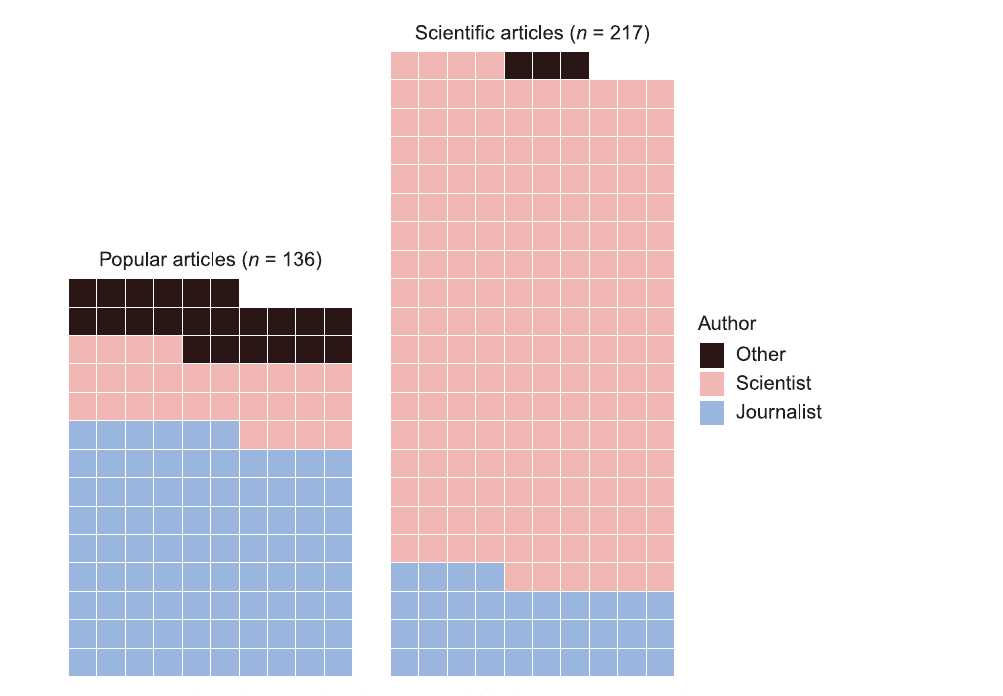
Fig 1. Data set by audience and author type. Each block represents one article.